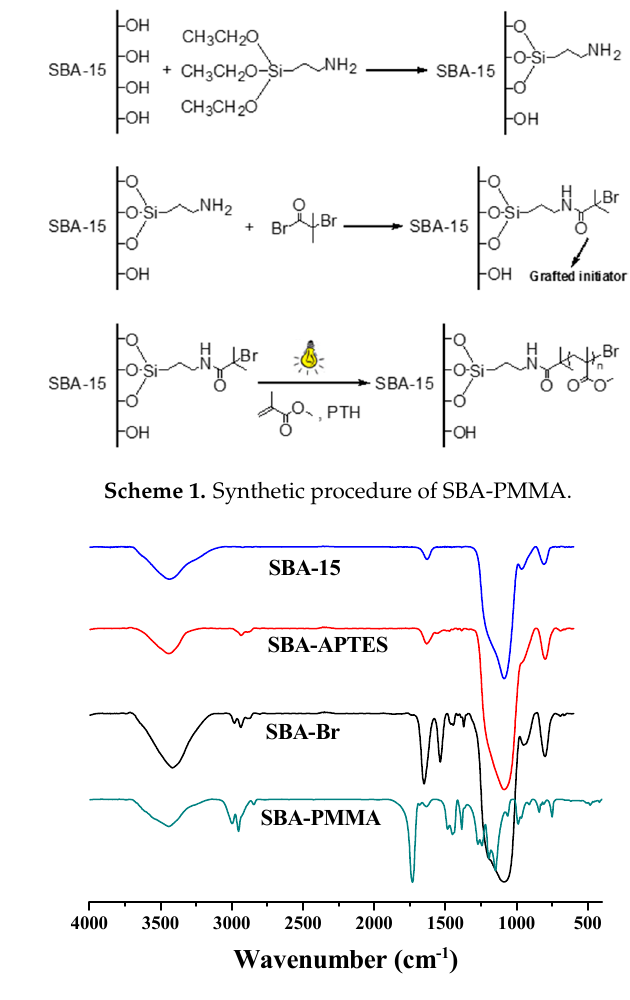
Figure 2. XPS spectra of SBA-15, SBA-APTES, SBA-Br, and SBA-PMMA. After these initial surveys, the polymerizations of different monomers, e.g., MMA, DMAEMA, and NIPAM, were carried out using SBA-Br as the initiator, ethyl 2- bromoisobutyrate (EBiB) as the co-initiator and PHT as the photocatalyst under the irradiation of a xenon lamp with a 380 nm optical filter at 30 °C. The light intensity was 3.0 mW/cm 2 . The polymerization results are summarized in Table 1. The molecular weight of the PMMA